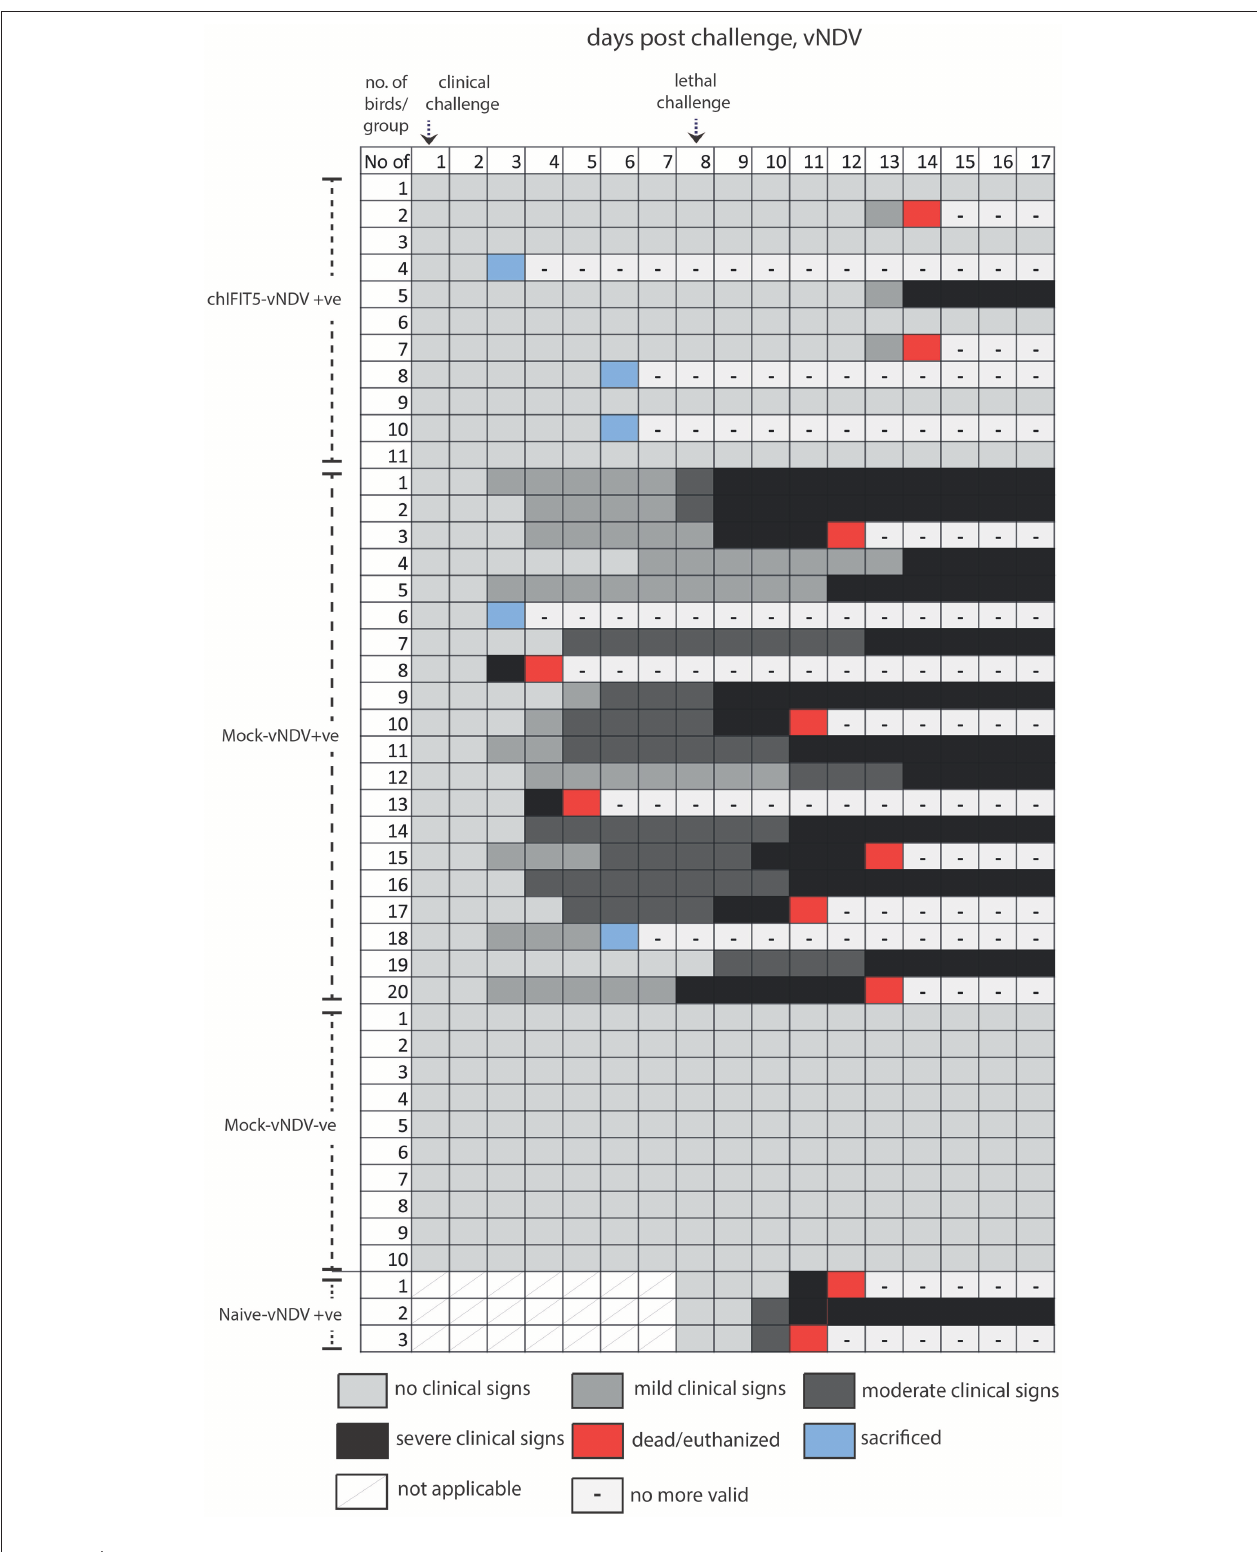
Frontiers in Immunology | www.frontiersin.org